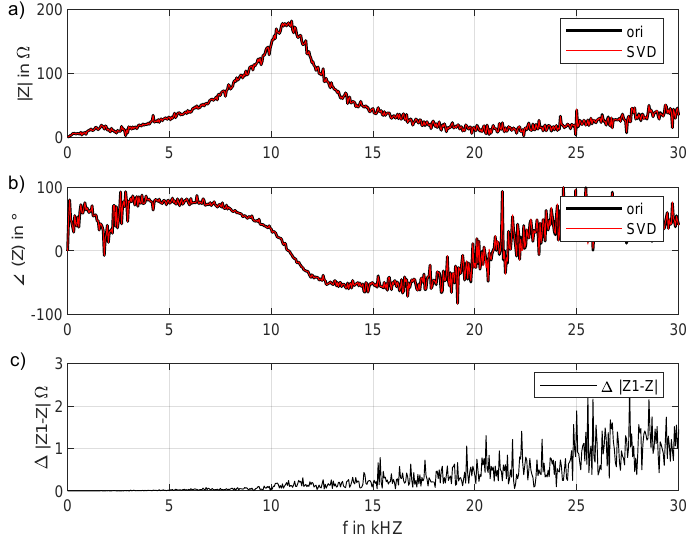
Figure 11. Impedance measurement results of the SVD, for explanation see Figure